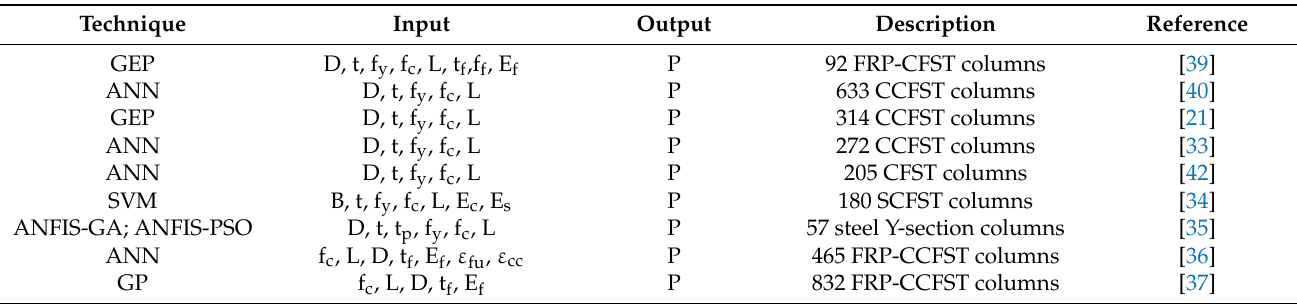
Table 1. Review studies for application of artificial intelligence (AI) for the composite columns.